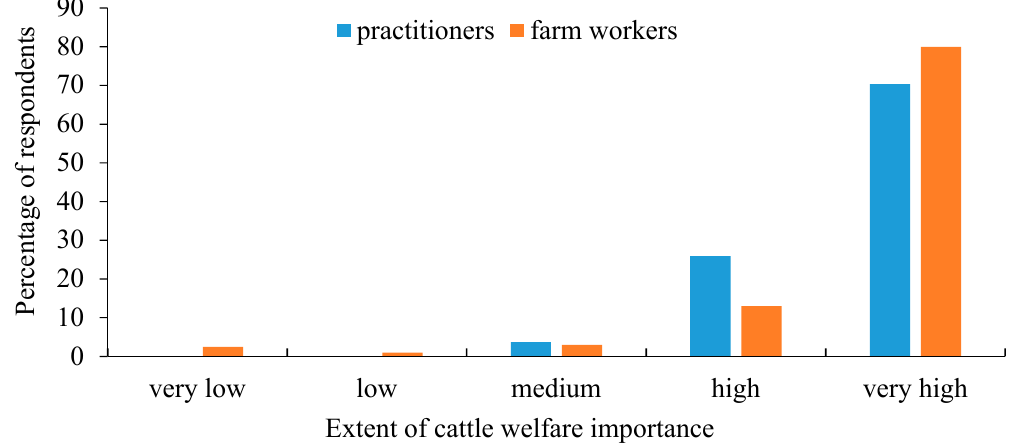
Figure 2. Importance of cattle welfare as perceived by veterinary practitioners ( n = 27) and farm workers ( n = 429). There were statistical differences between groups. Table 1. Distribution (in percentages) of veterinary practitioners’ answers to questions regarding senses, memory, and pain perception ( n = 27).